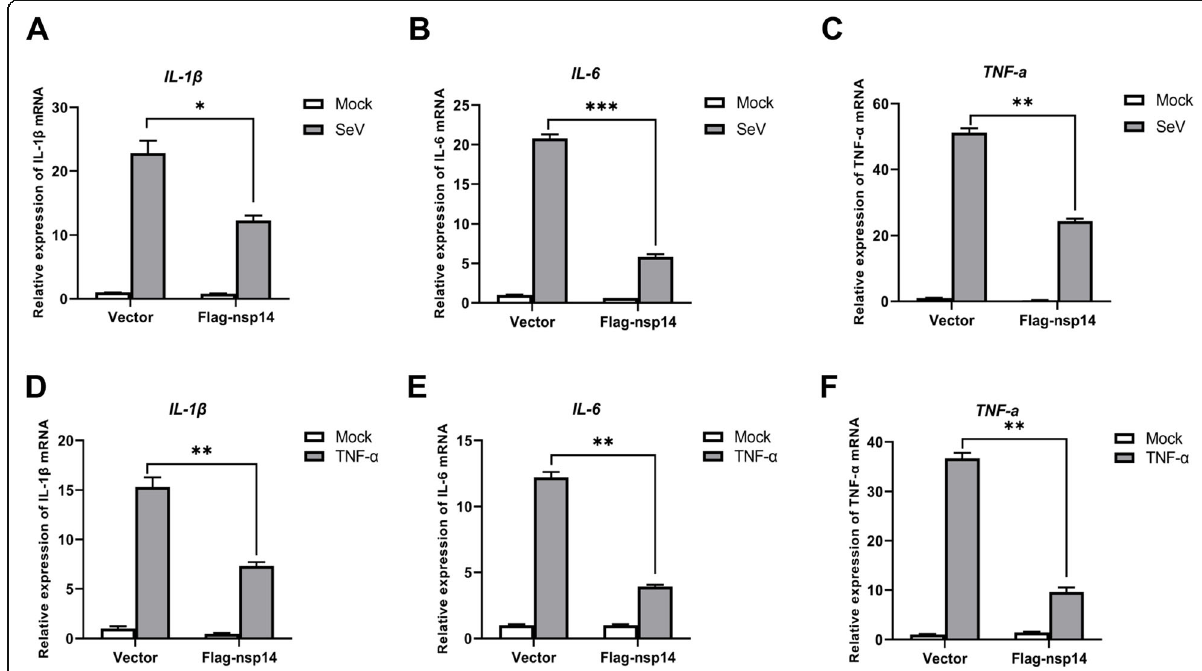
Fig. 3 PEDV nsp14 suppressed the expression of proinflammatory cytokines in porcine intestinal epithelial cells. A-C IPEC-J2 cells were transfected with 1 μ g vector plasmids or Flag-nsp14 expression plasmids. At 24 hpt, cells were infected with SeV for 24 h, and mRNA levels of IL-1 β ( A ), IL-6 ( B ) and TNF- α ( C ) were measured via qPCR analysis. D , E IPEC-J2 cells were transfected with 1 μ g vector plasmids or Flag-nsp14 expression plasmids. At 24 hpt, cells were treated with TNF- α (30 ng/mL) or mock-treated for 8 h, and mRNA expression levels of IL-1 β ( D ), IL-6 ( E ) and TNF- α ( F ) were measured via qPCR analysis. *, P < 0.05 ; **, P < 0.01; *** P <